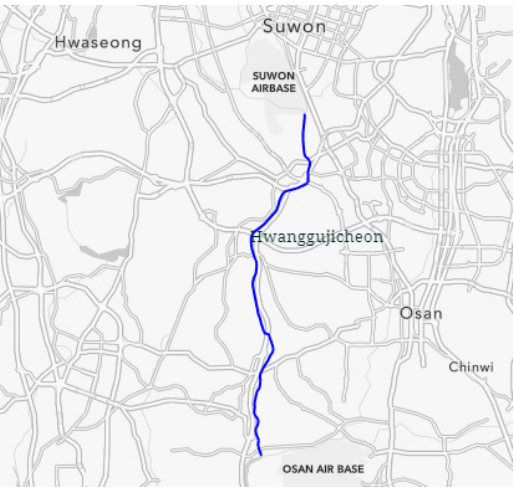
Figure 3. Areas of the study. Table 1. Latitude and longitude of the area of research.